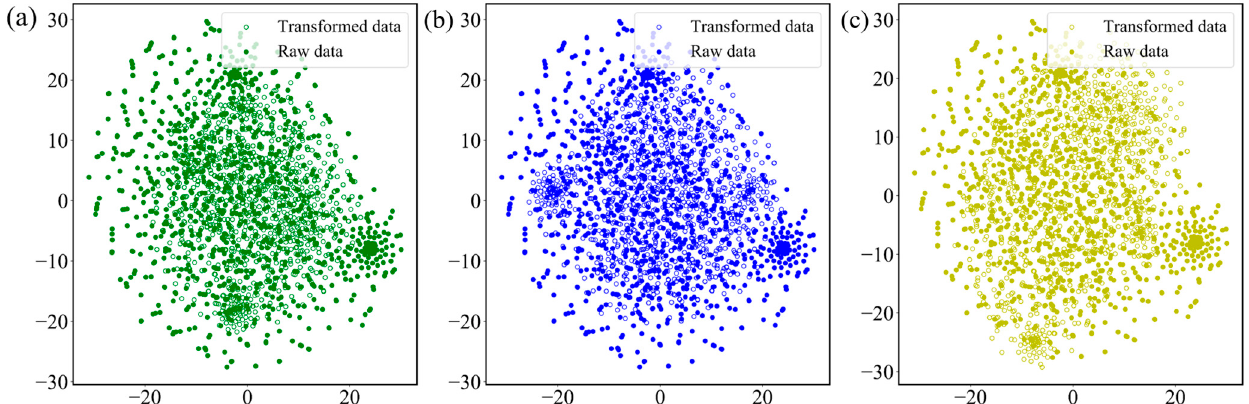
Figure 2. Visualization of the augmented comparison plot of the RadioML2016.10b dataset using t-SNE. The hollow shape is the generated time series and the solid shape is the original time series. ( a ) Scaling; ( b ) magnitude warping; ( c ) time warping.